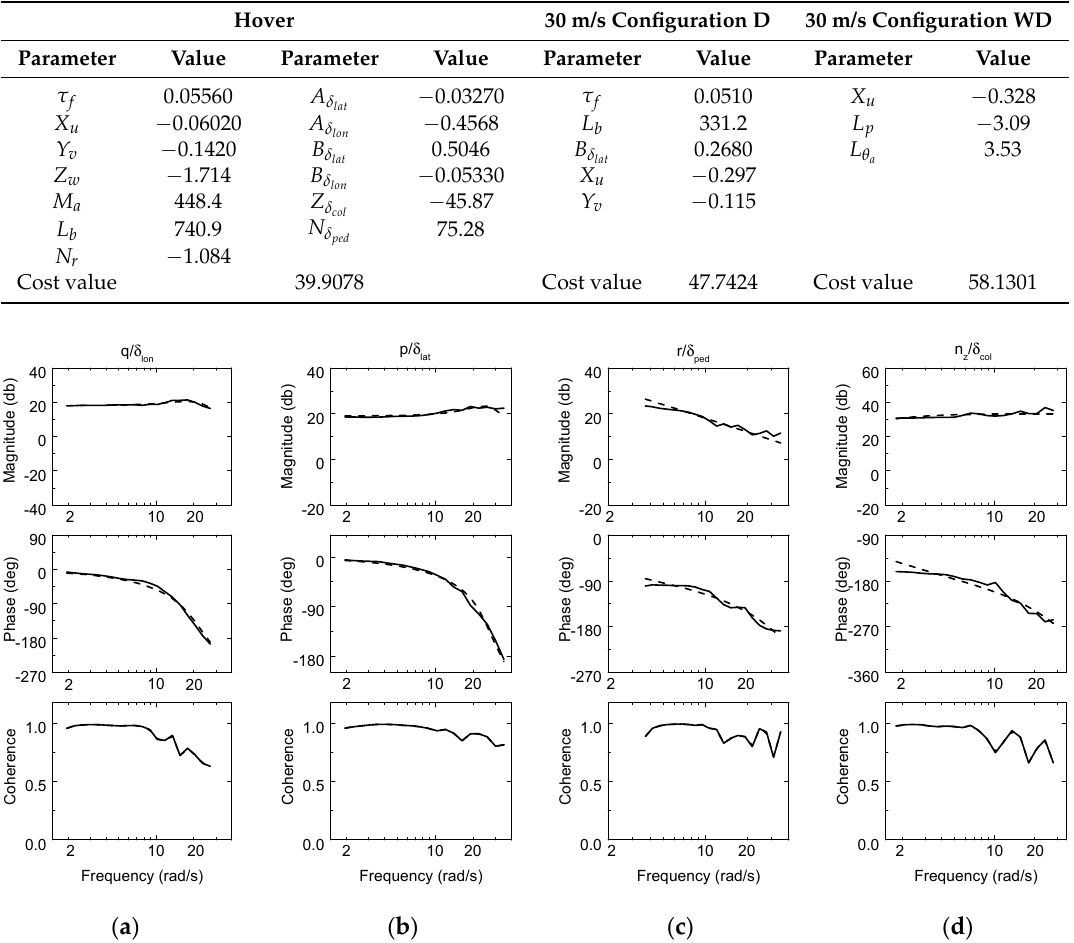
Figure 7. Frequency domain comparisons of IDM and flight responses in hover condition. (Solid line: flight responses; Dash line: IDM results). ( a ) q / δ lon ; ( b ) p / δ lat ; ( c ) r / δ ped ; ( d ) n z / δ col